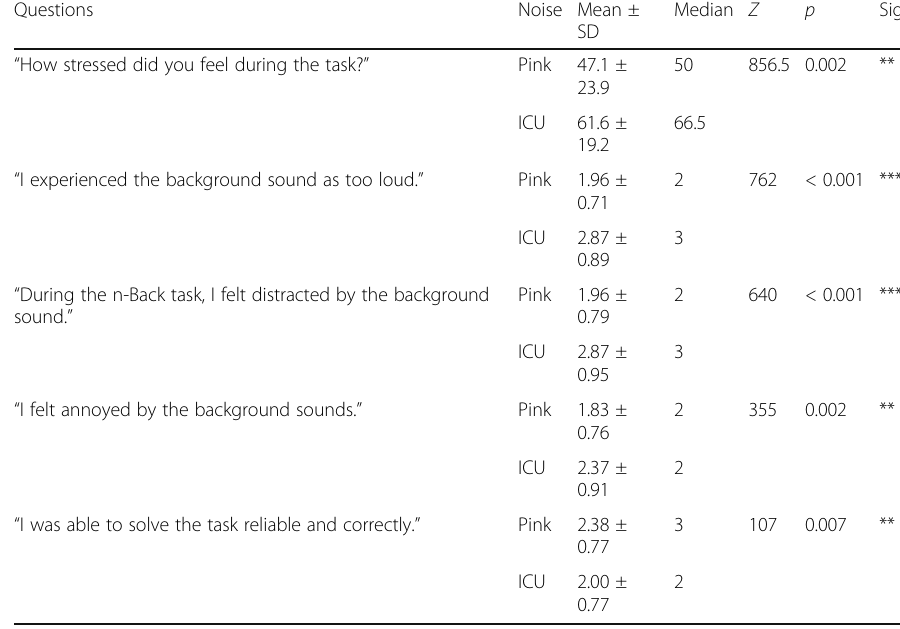
Table 3 Results of post-task questions about perceived strains by noise conditions Questions Noise Mean ±